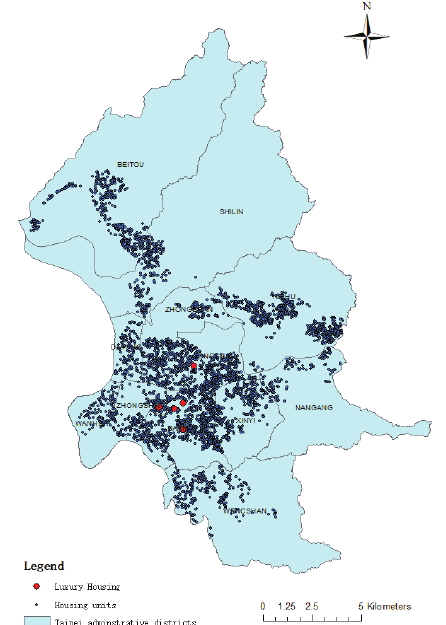
Figure 3. Luxury housing cases in Taipei City and